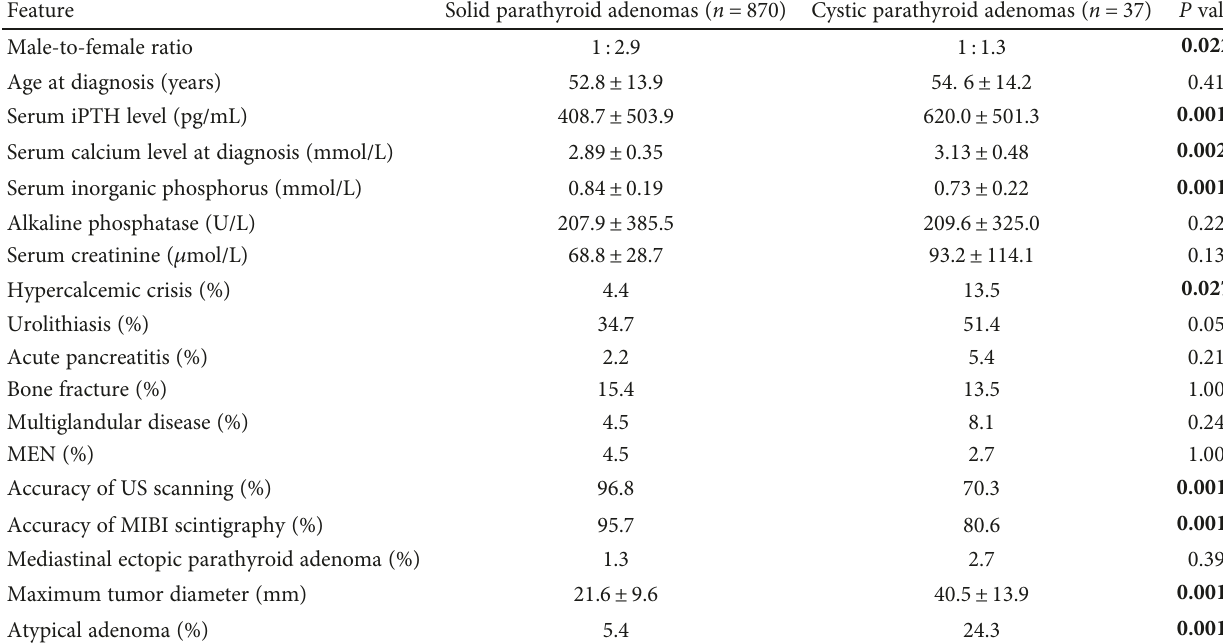
Table 1: Comparison of the clinicopathological features between patients with solid parathyroid adenomas and patients with cystic parathyroid